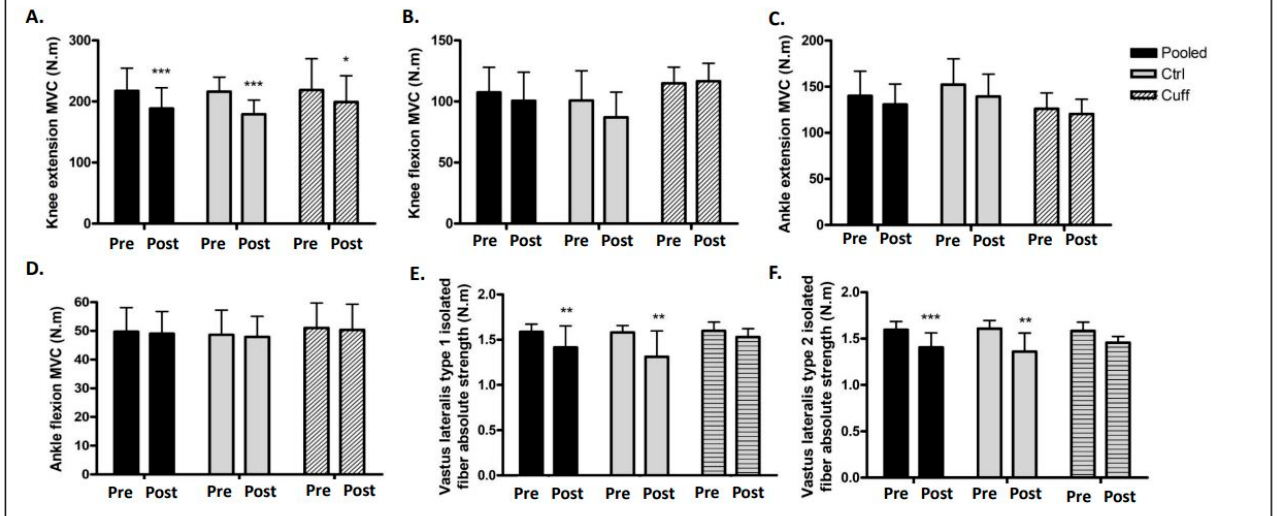
Figure 2. Effects of 5 days of DI on muscle and fiber strength. Muscle maximal isometric voluntary contraction access by isocinetic dynamometer (N.m) expressed in both groups and pooled subjects. ( A ) Knee extension measurement. ( B ) Knee flexion measurement. ( C ) Ankle extension measurement. ( D ) Ankle flexion measurement. Isolated muscle fiber strength production by fiber type. ( E ). Type 1 isolated muscle fiber contraction. ( F ). Type 2 isolated muscle fiber contraction. *: different from pre value in the same group. * p < 0.05; ** p < 0.01; *** p < 0.001.